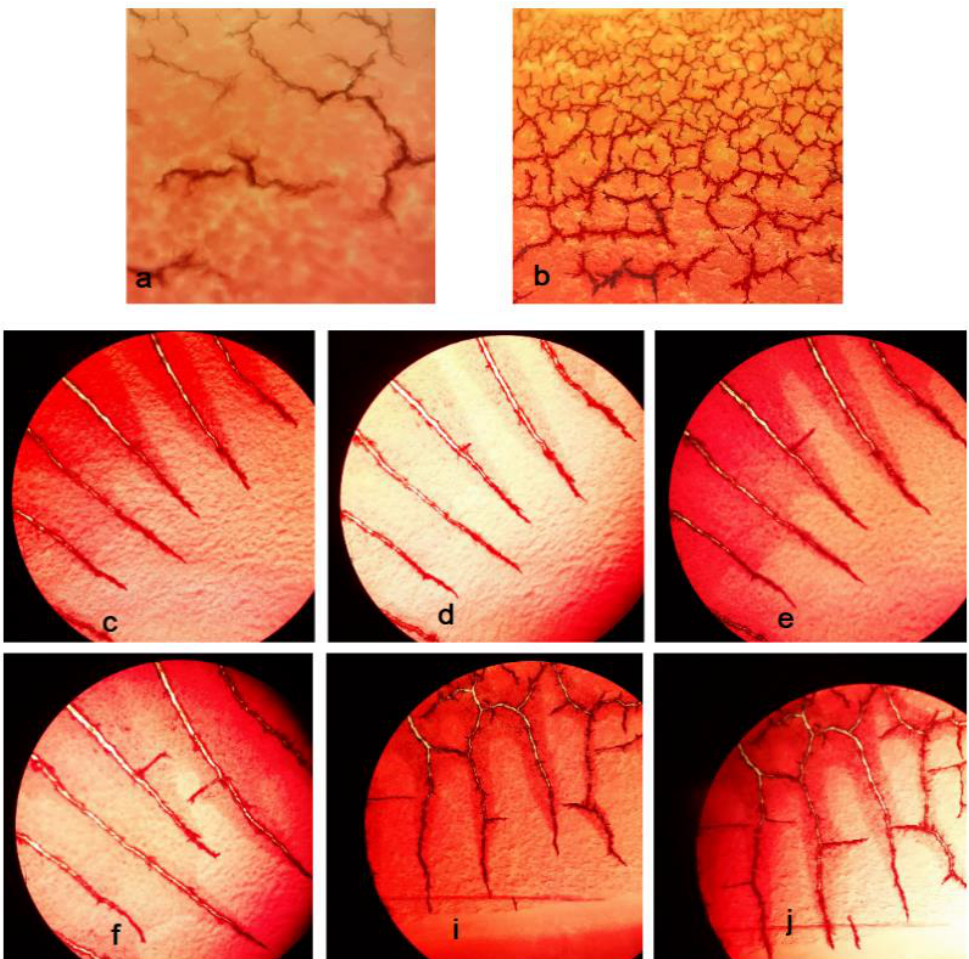
Figure 11. The time points of the fibrin formation process under a light microscope (100 × ): ( a ) on the production sponge at the time of 30 s, ( b ) on the production sponge at the time of 70 s, and ( c – j ) related to the blood droplet from 180 to 240 s.